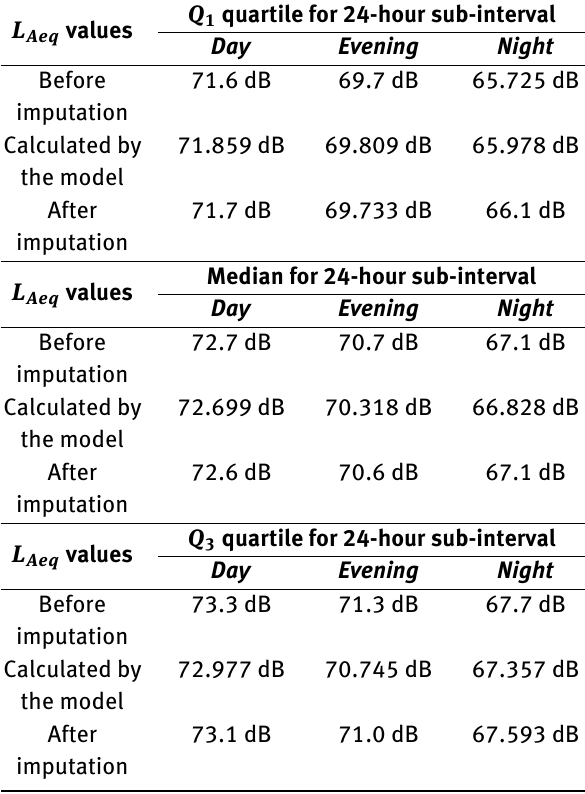
Table 6: Selected parameters of the model at location no. 3